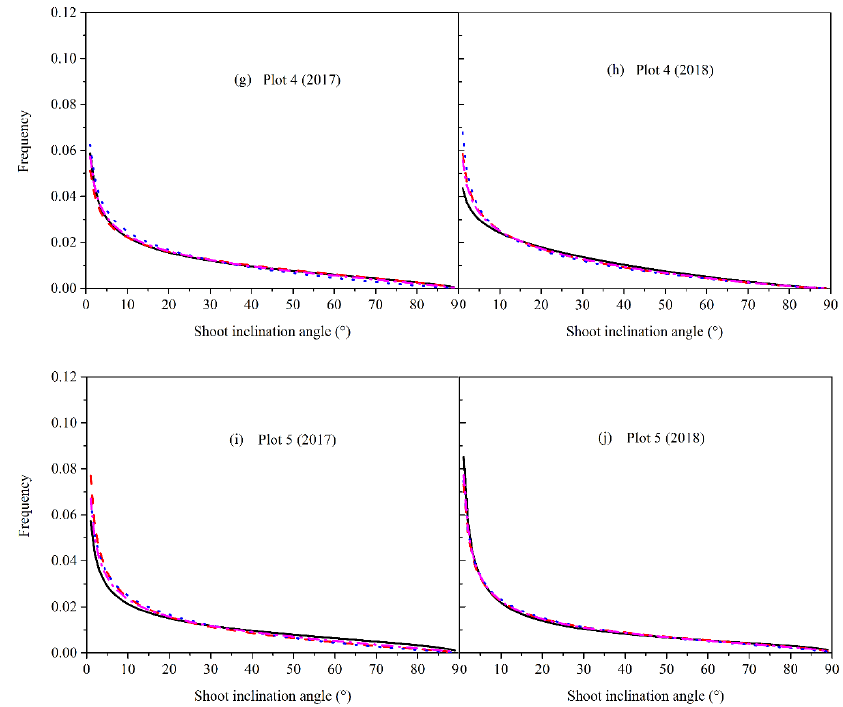
Figure 6. Vertical and annual variations in shoot inclination angle distribution in the five plots in 2017 and